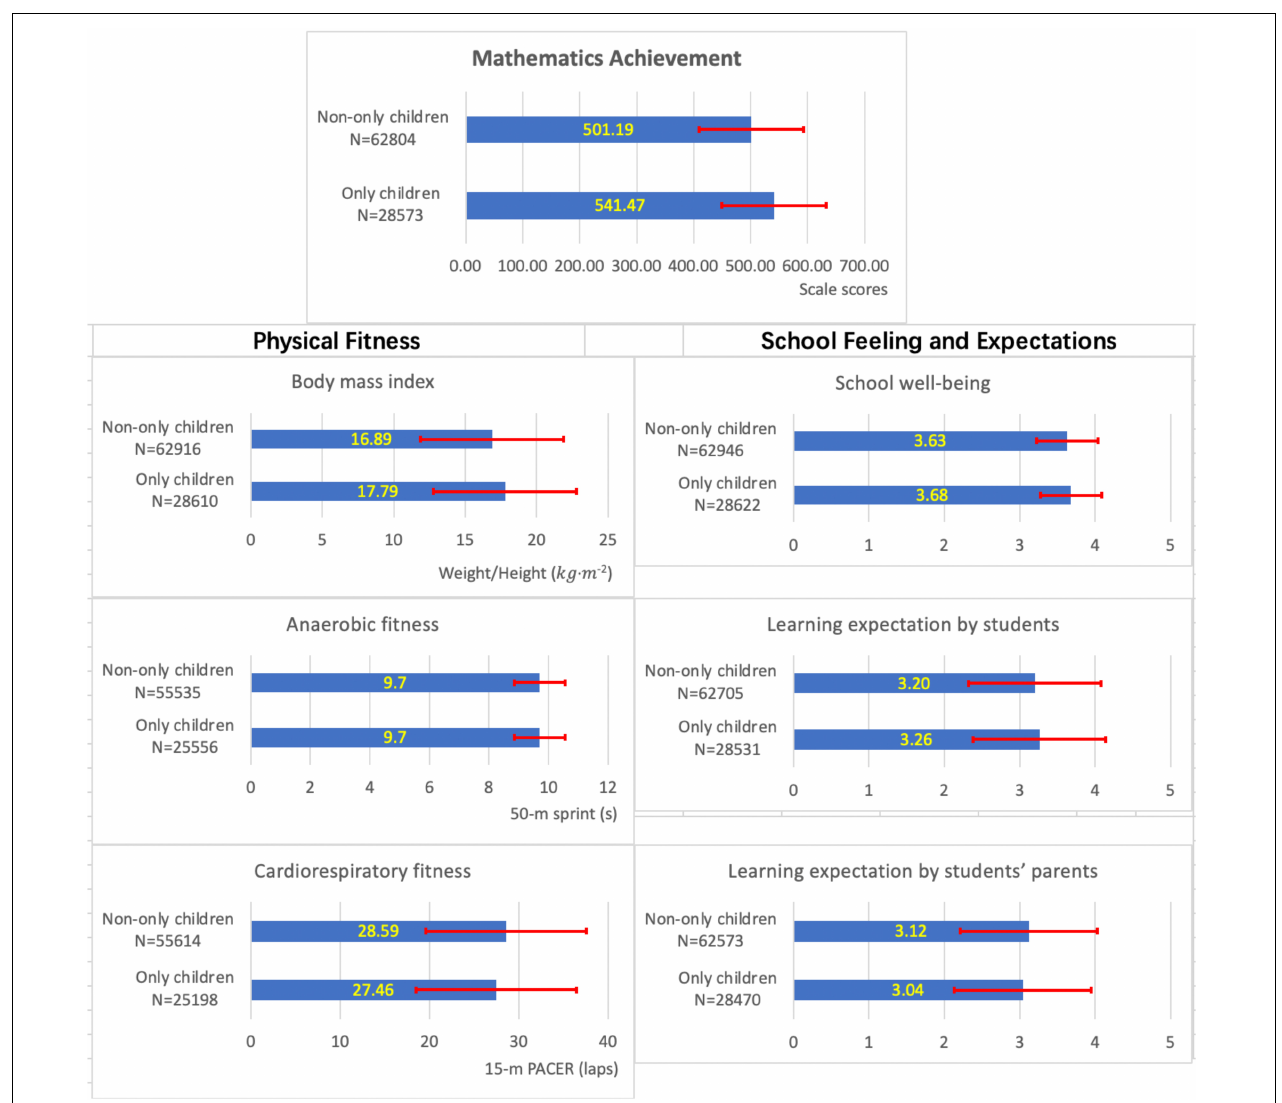
FIGURE 1 | Outcomes of only children and non-only